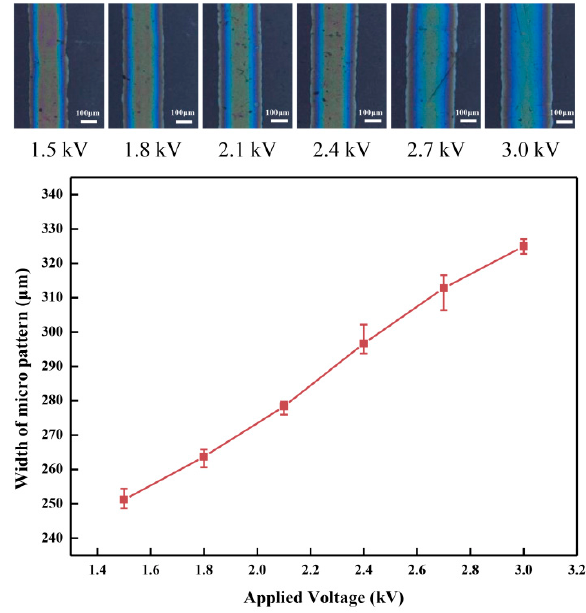
Figure 5. E ff ect of the applied voltage on the organic micro pattern Figure 5. Effect of the applied voltage on the organic micro pattern width.